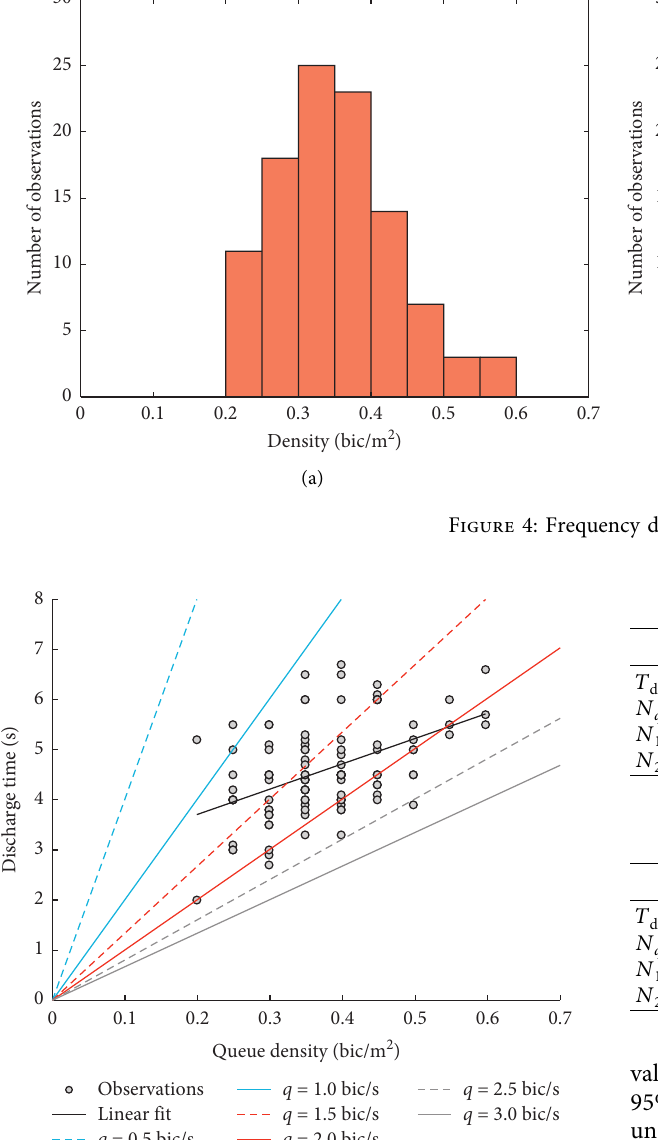
Figure 5: Observed discharge time and jam density (dots) and the linear regression fit (black line). The lines starting from the origin indicate different flow rates in bic/s over the full width of the cycle path (3m).